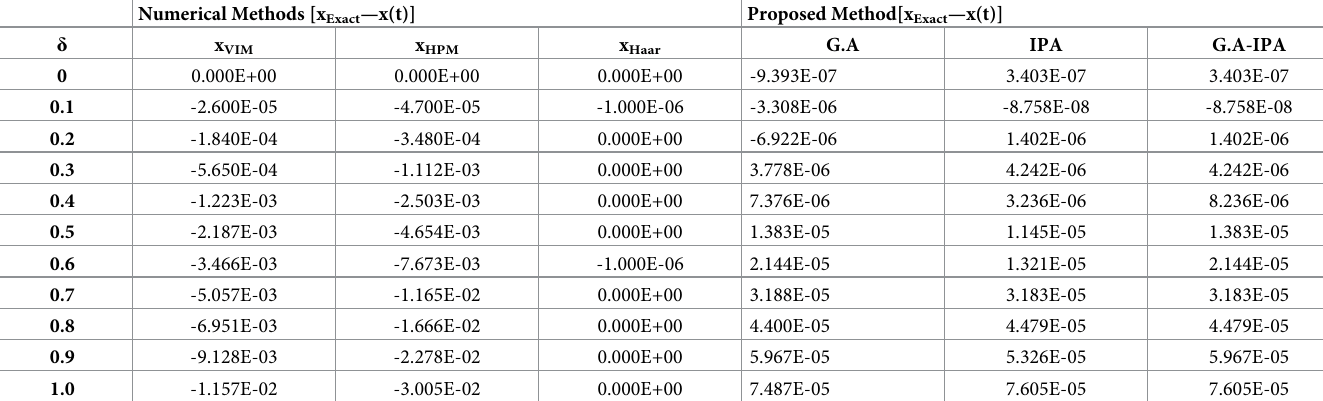
Table 19. Comparison of absolute errors for different δ and t =